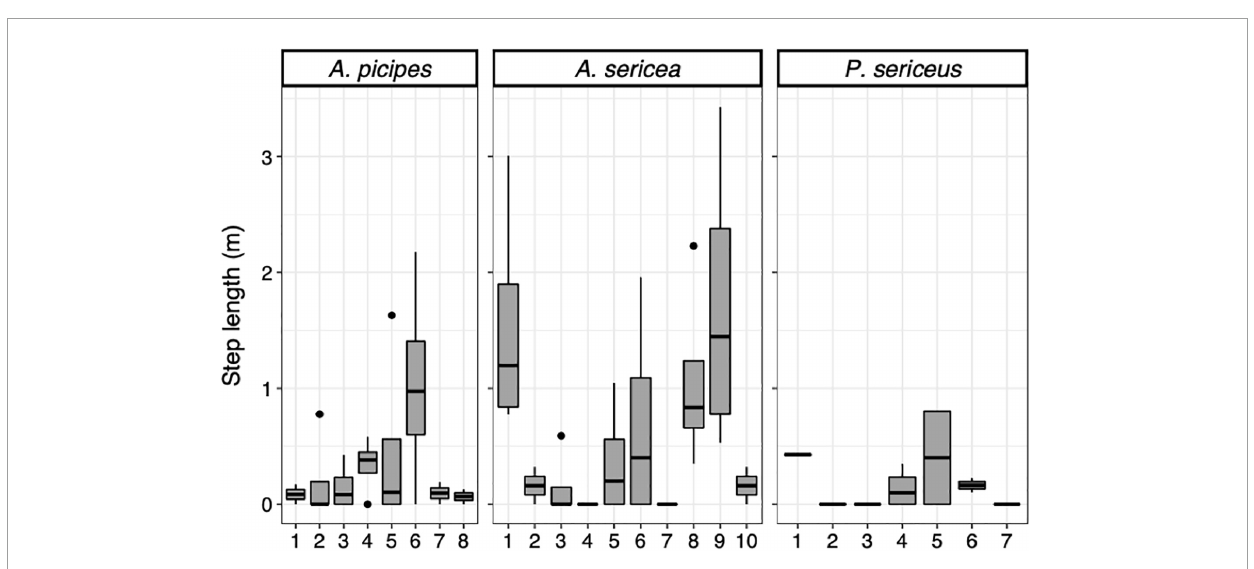
FIGURE6 Step length in metre during night time per individual and